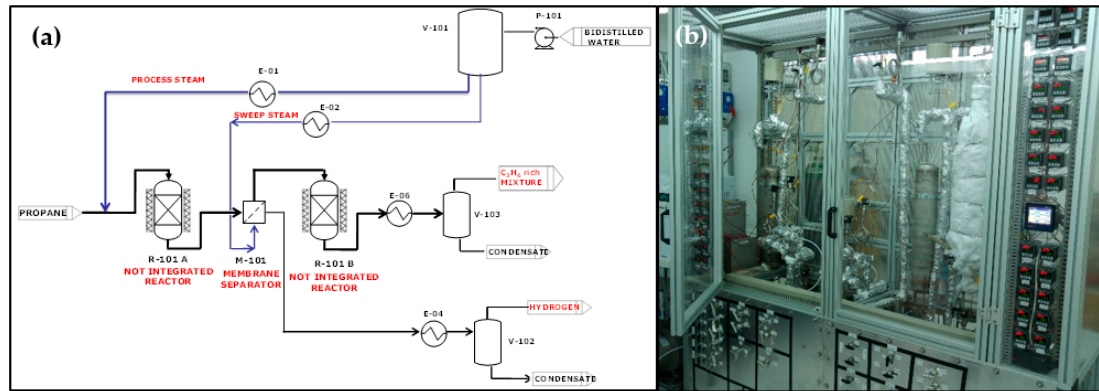
Figure 4. Propylene production membrane reactor ( a ) Process scheme; ( b ) Pilot unit assembly.